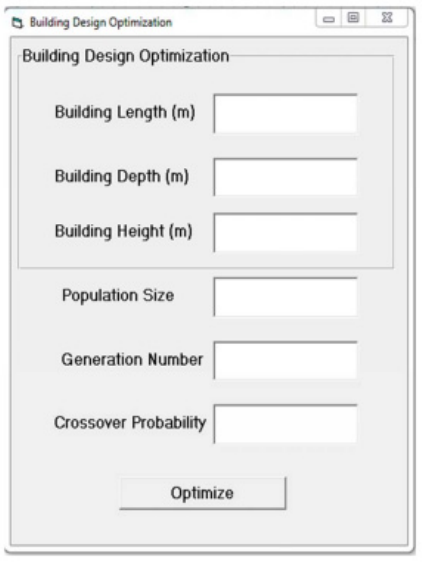
Figure 5. Developed optimization VB application.